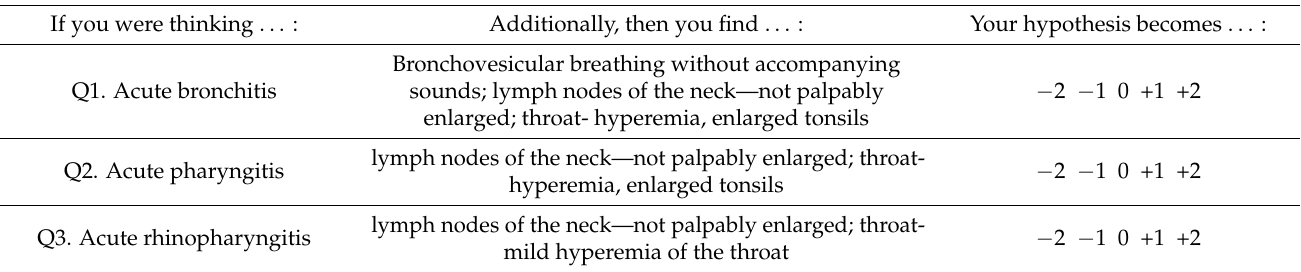
Table 1. Example of